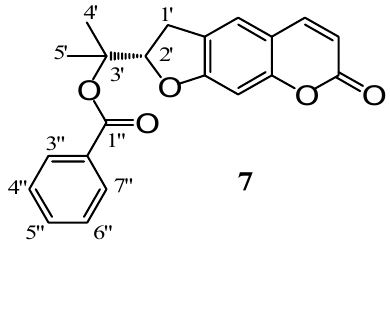
Figure 3. Structure of